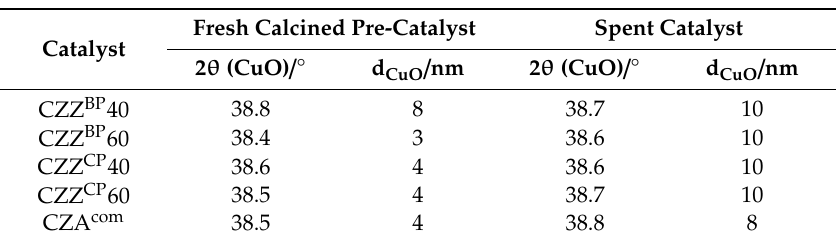
Table 2. Estimated average CuO crystallite sizes according to Scherrer equation from XRD measurements of the fresh pre ‐ catalysts and the spent catalyst after activity test. Main CuO reflection 2 θ received from deconvolution of XRD pattern using Gauss fit.